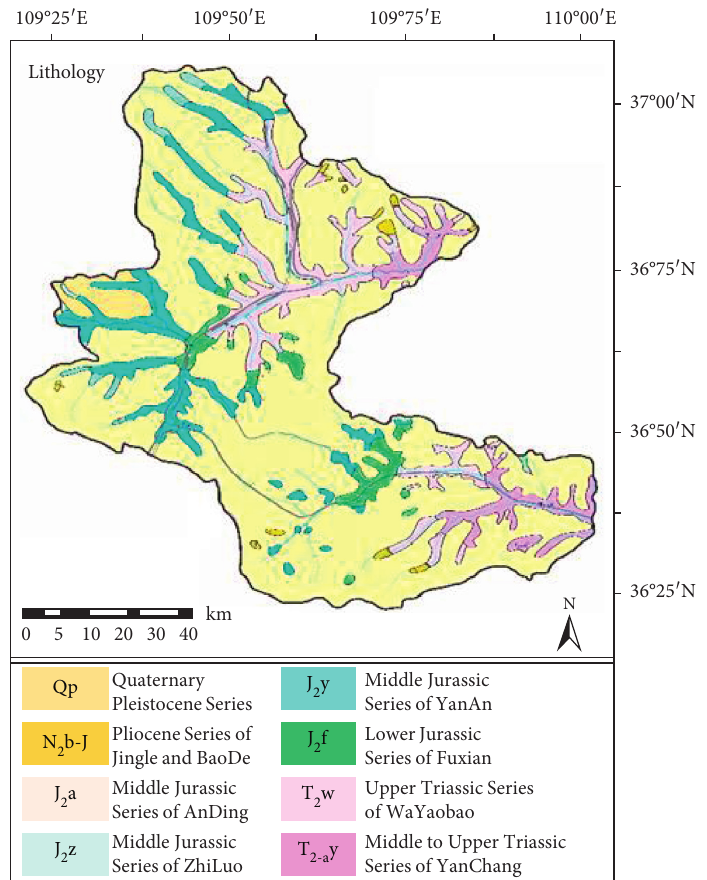
Figure 4: The strata in the study area: Baota District, Yan’an city. Figure from the Department of Survey, Government of Xi’an.